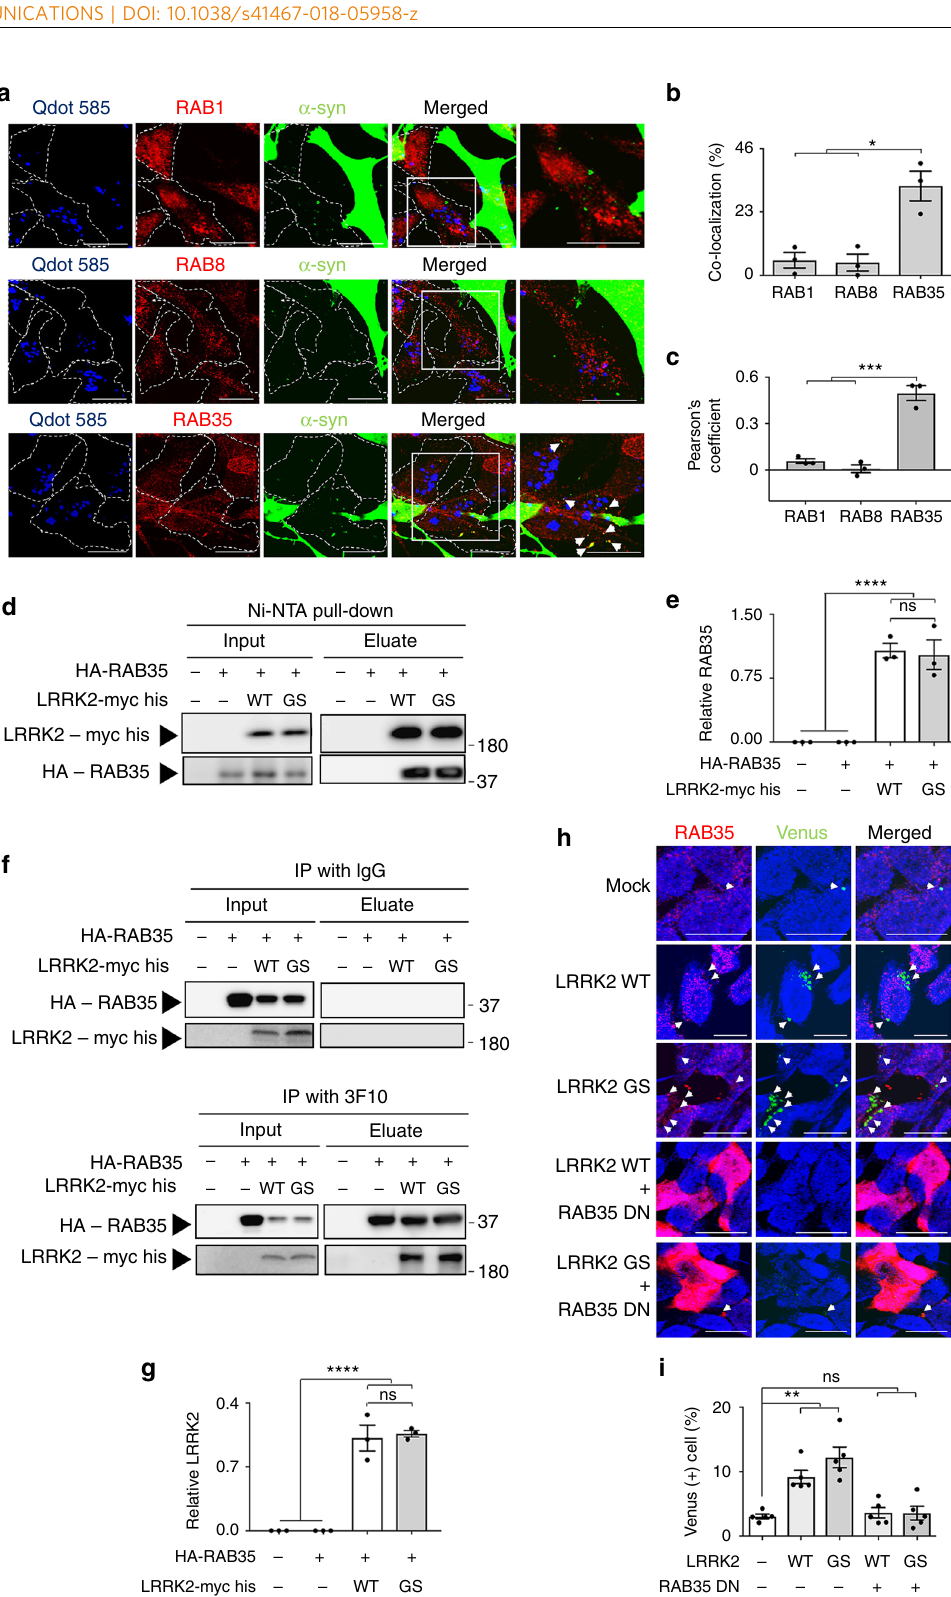
localization of α -synuclein to the RAB35-positive